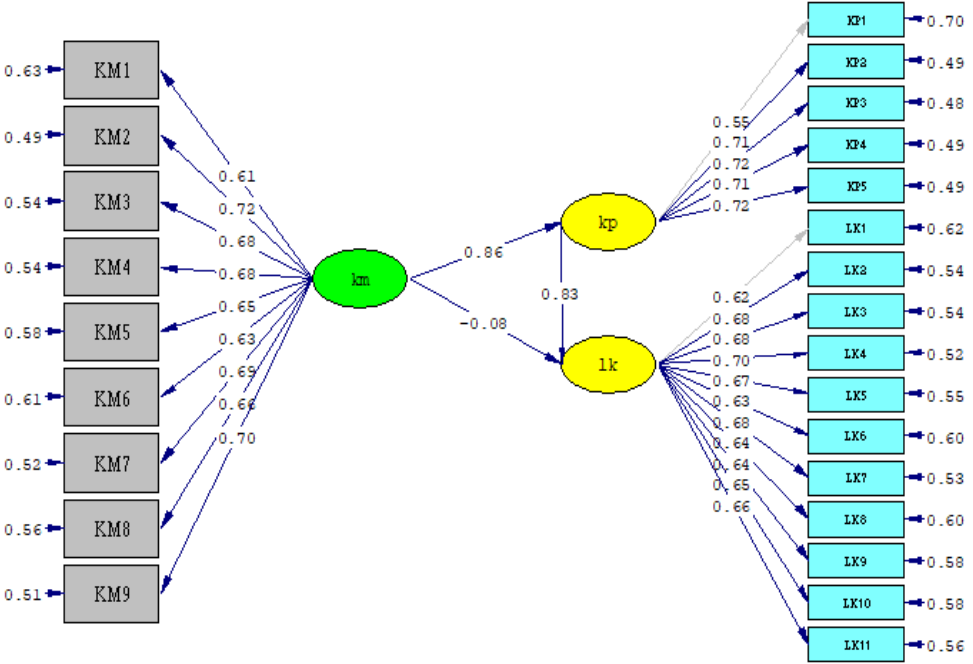
Figure 2. Measurement model fit test results